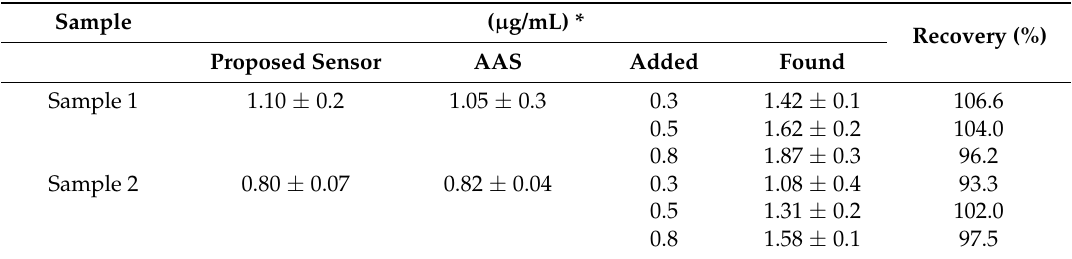
Table 3. Application of the proposed sensor to determination of Cu 2+ ions in tap water samples.